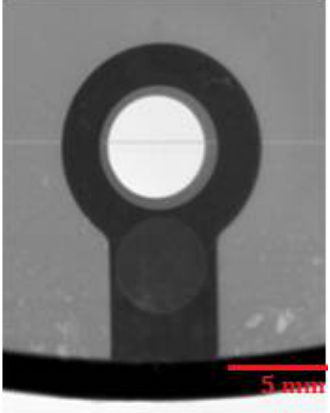
Figure 16. RTG—Sample 1.B.